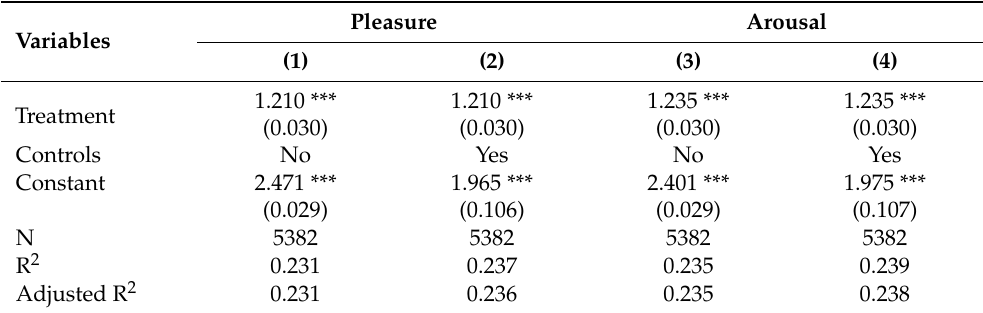
Table A1. The effect of overall intervention on tourists’ momentary emotional experience.